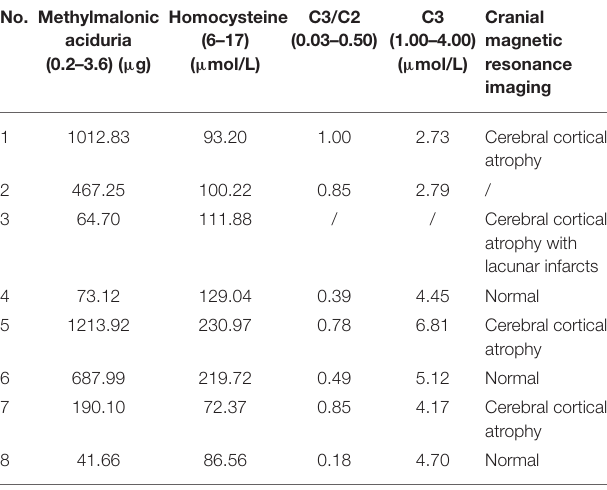
TABLE 2 | Accessory examinations 8 late-onset cblC